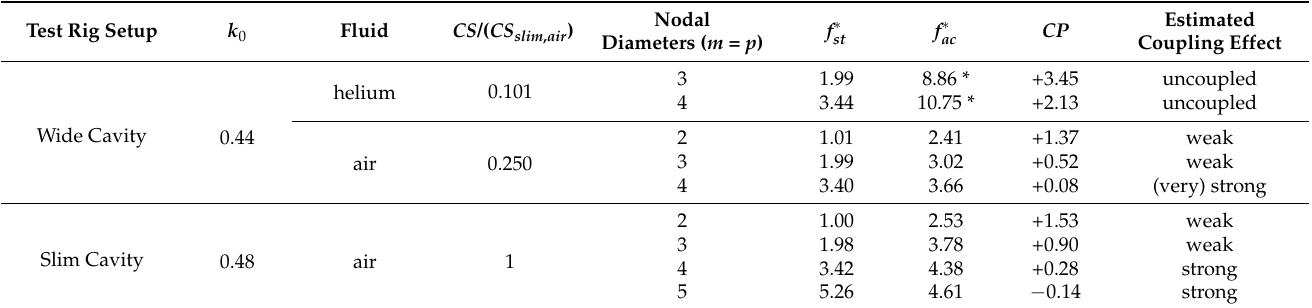
Table 2. Overview of excited mode couples (with n = q = 0) in test rig at UDE. The coupling strength is calculated for 0.1 MPa and 295 K. Values of the coupling strength parameter are normalized as a ratio of the respective value to that for the case of air in the “slim